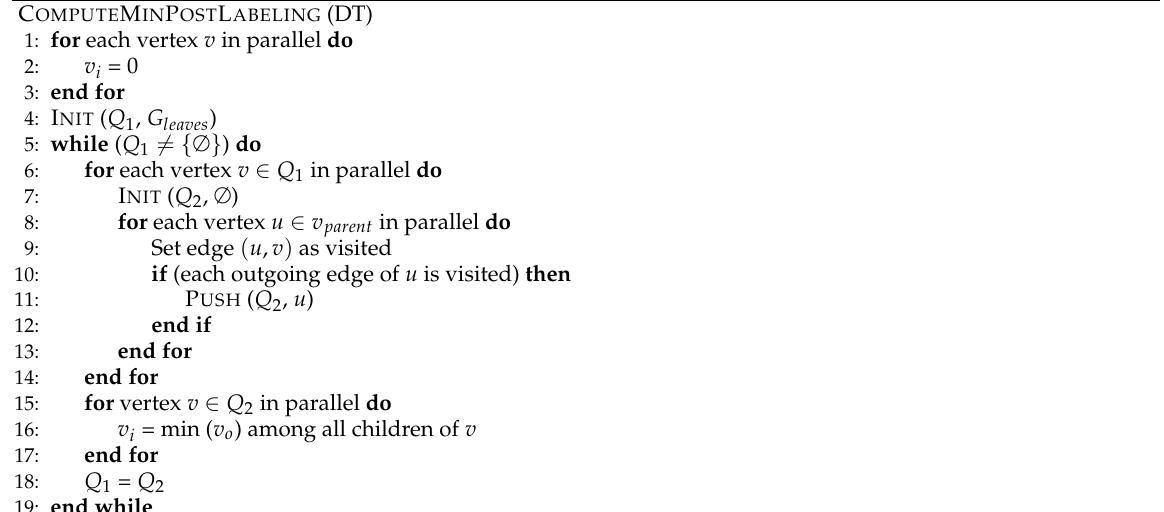
Algorithm 6 Step 4: Min-post labeling computation with a bottom-up BFS. C OMPUTE M IN P OST L ABELING